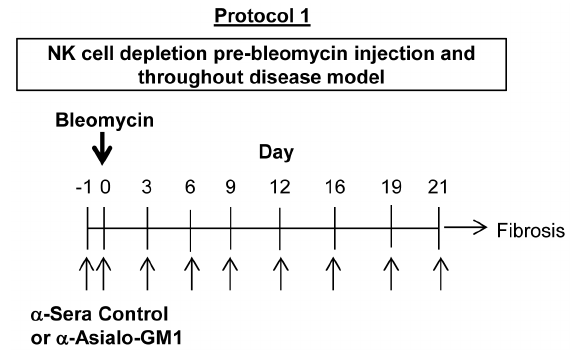
Figure 2. NK cell depleting anti-asialo GM1 antibody treatment protocol during bleomycin induced pulmonary fibrosis. Pro- tocol 1 : depicts the treatment of mice with either control sera or anti- asialo GM1 antibody to deplete NK cells during BIPF. Mice were given eight injections of depleting antibody or control sera at the indicated times before and after i.n. bleomycin dosing.